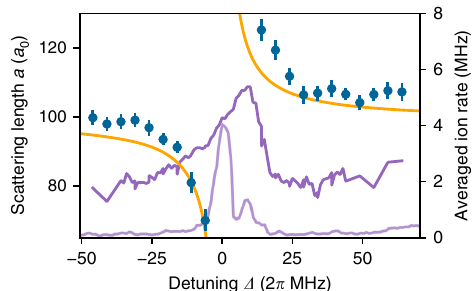
Fig. 3 Rydberg optical Feshbach resonance. Measured scattering length (blue dots) for different detunings Δ around the photoassociation resonance to the Rydberg molecule shown in Fig. 1, for an atomic Rabi frequency of 2 π × 810 kHz. As a reference the on-site interaction for the uncoupled system is U ref = h × 2110(20) Hz. A change of scattering length of ±30 a 0 thus corresponds to an interaction shift of about ±600 Hz. The depicted resonances are the averaged ion rate (right scale) within the same measurement procedure over a hold time of τ = 450 μ s and the same driving strength (purple) and with a reduced Rabi frequency of 2 π × 230 kHz (light purple). The orange curve is a simpli fi ed theoretical model using the experimentally measured atomic Rabi frequency and resonance position (see text). Error bars correspond to statistical errors from the fi tting